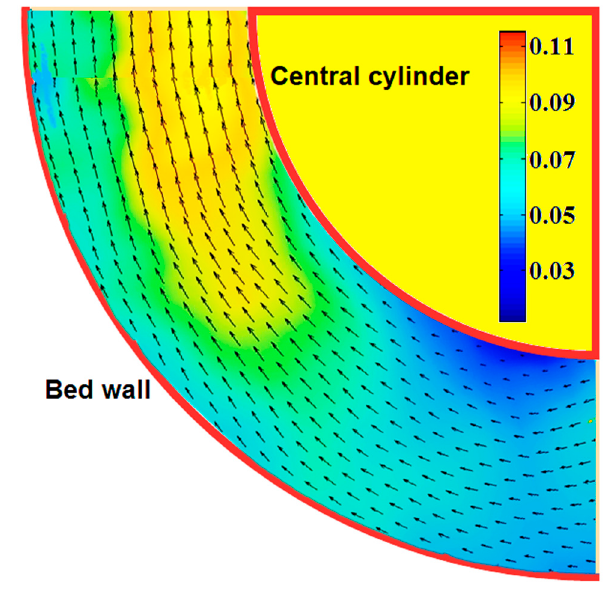
Figure 4. Typical velocity vector field of a quarter bed.